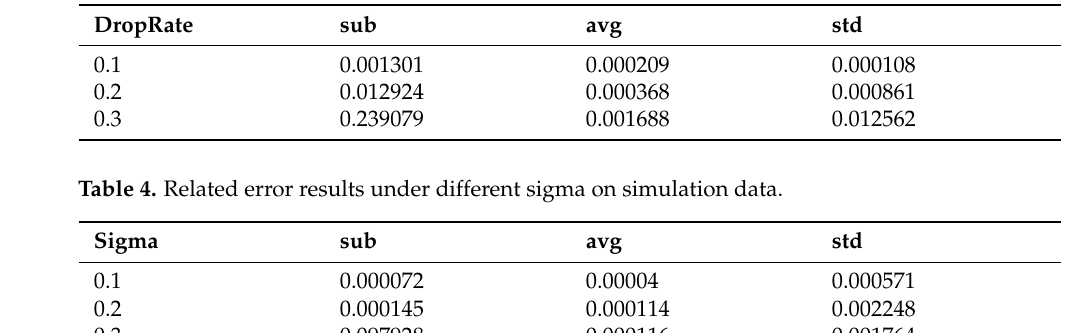
Table 3. Related error results under different drop rates on simulation data.